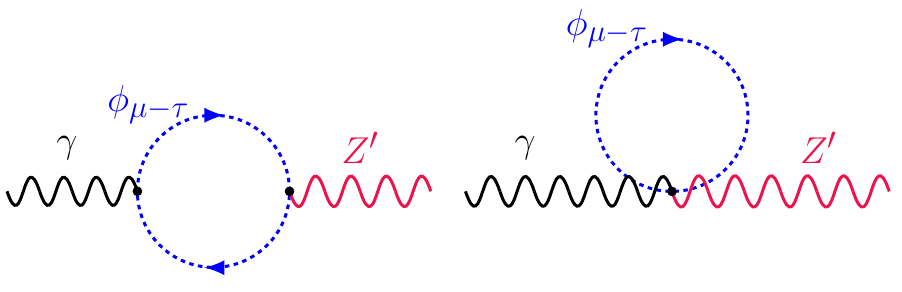
Figure 8 . Contributions to the (cid:13) (cid:0) Z 0 kinetic mixing from heavy scalar